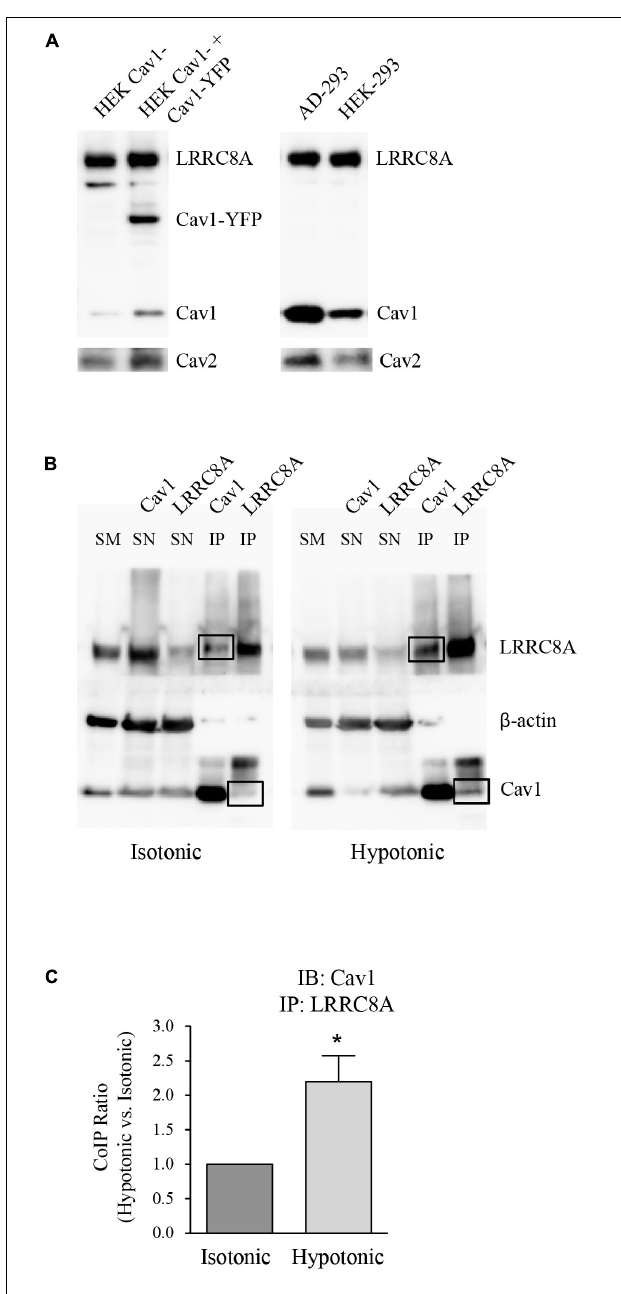
FIGURE 1 | Expression and molecular association of LRRC8A and caveolin proteins. (A) Left: Representative western blot (WB) showing the endogenous expression of LRRC8A, Cav1, and Cav2 (after stripping off the Cav1 primary antibody), in non-transfected HEK Cav1- cells. Expression of these endogenous proteins in addition to Cav1-YFP was also determined in HEK Cav1- cells after transfection with Cav1-YFP. Right: Representative WB comparing endogenous LRRC8A, Cav1, and Cav2 (after stripping) in AD 293 and HEK 293 cell lines, both enriched with Cav1. (B) Representative blots of protein extracts subjected to immunoprecipitation. Endothelial HEK 293 cells exposed to either isotonic or hypotonic extracellular solutions were lysed and total protein extracts were immunoprecipitated using either Cav1 or LRRC8A-specific primary antibodies. Negative controls were done by the absence of antibodies and by immunoprecipitation with normal rabbit IgG,